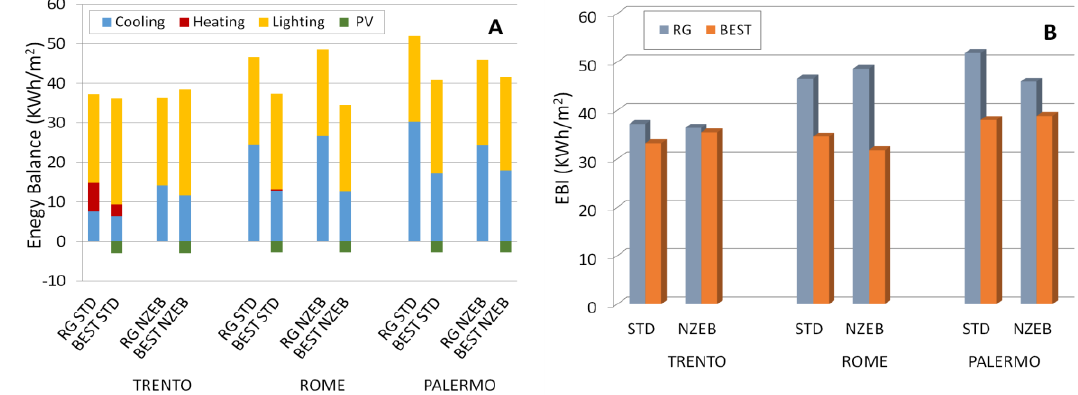
Figure 12. ( A ) Energy balance for the BEST solution compared to the reference glass (RG) of the STD and NZEB models on the E/W orientation of the building; ( B ) EBI index evaluated for the same exposure and glazing elements. Table 8. Percentage differences between the EBI calculated for RG and BEST, in the cases of the STD and NZEB models at the three locations.